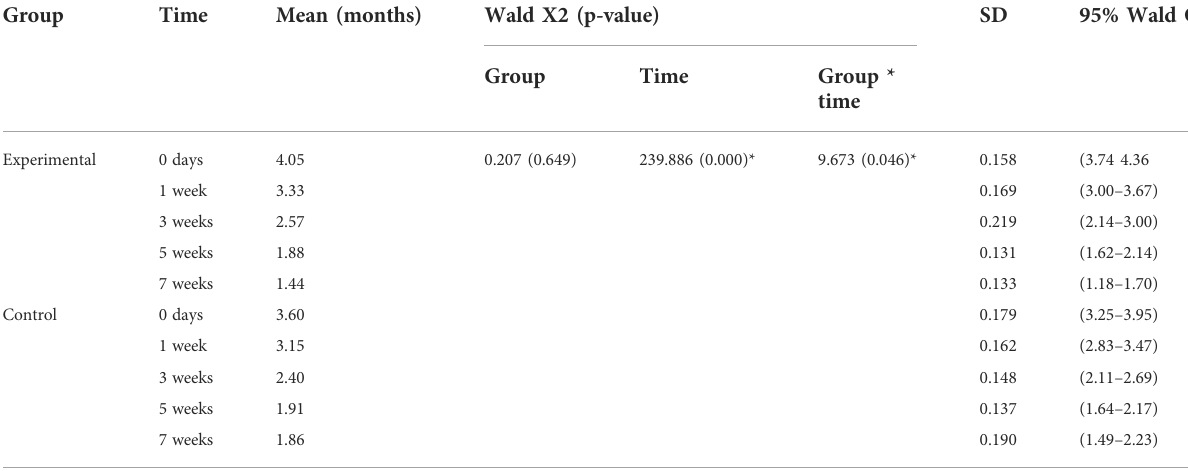
TABLE 5 Statistical analysis of periodic changes in granulation tissue percentage in the two groups. Group